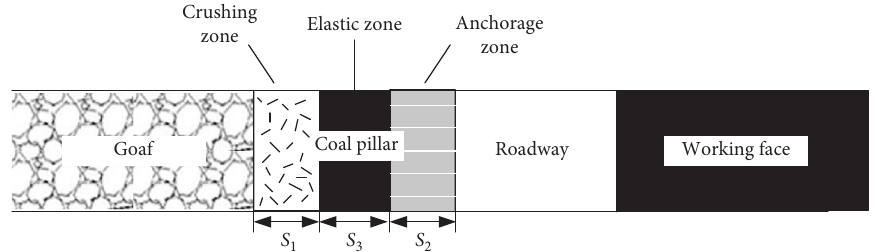
Figure 3: Schematic of roadway driving along the goaf and the small coal